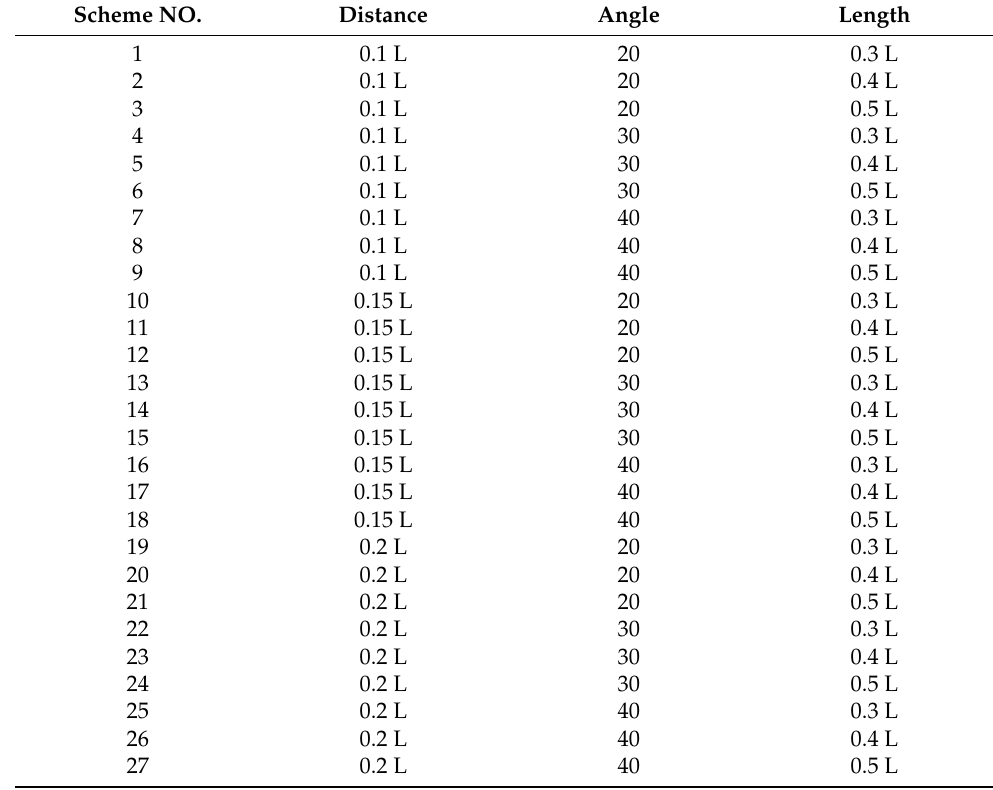
Table 1. Schemes under different distances.